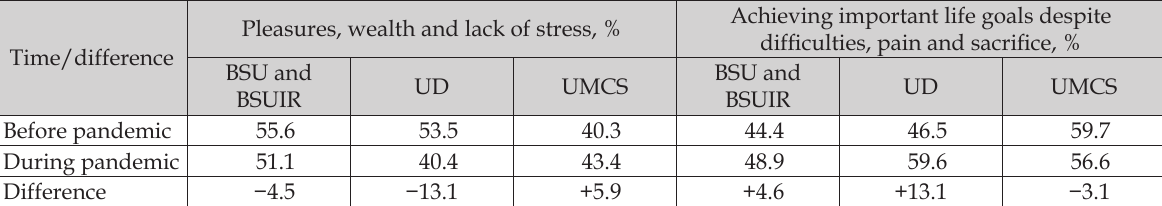
Table 3. Students’ life preferences in Lublin, Kyiv and Minsk before and during the pandemic, % (n = 380). Pleasures, wealth and lack of stress, Time/difference